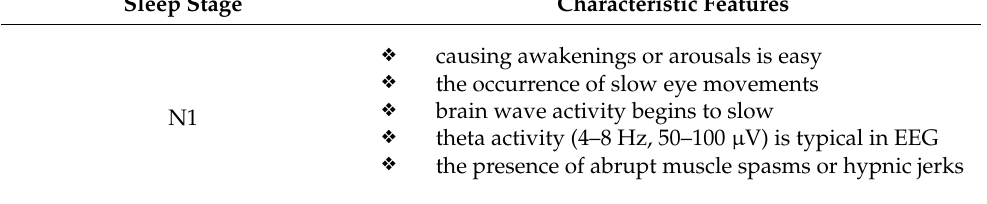
Table 1. Characteristic features of sleep stages.